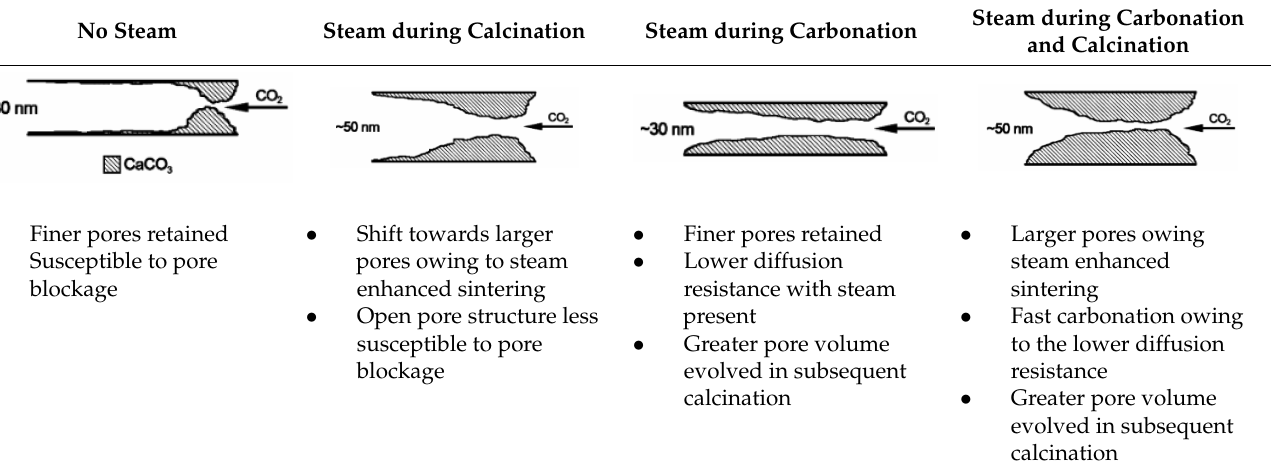
Table 4. Schematic representation of the relationship between sorbent morphology and conversion without steam present, steam present during carbonation, steam during calcination and steam present for carbonation and calcination. (Reprinted with permission from [98]. 2012, Donat et al.) Steam during Carbonation No Steam Steam during Calcination Steam during Carbonation and